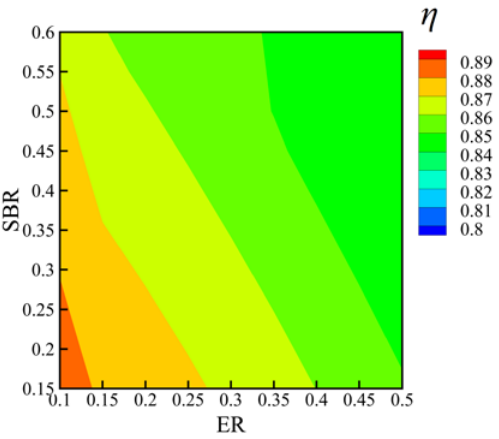
Figure 23. Exergy efficiency distribution at T = 900 K.